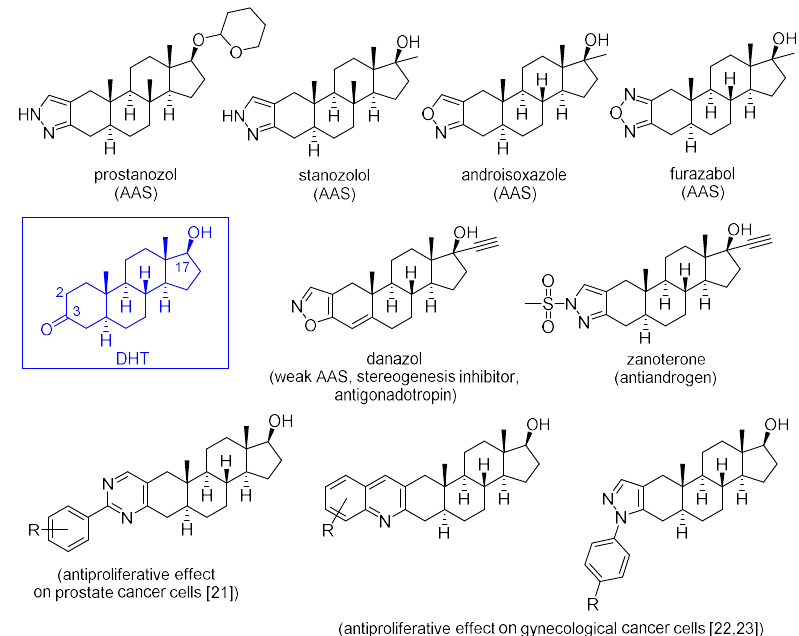
Figure 1. Ring-A condensed heterocyclic derivatives of dihydrotestosterone (DHT) with marked biological activities.